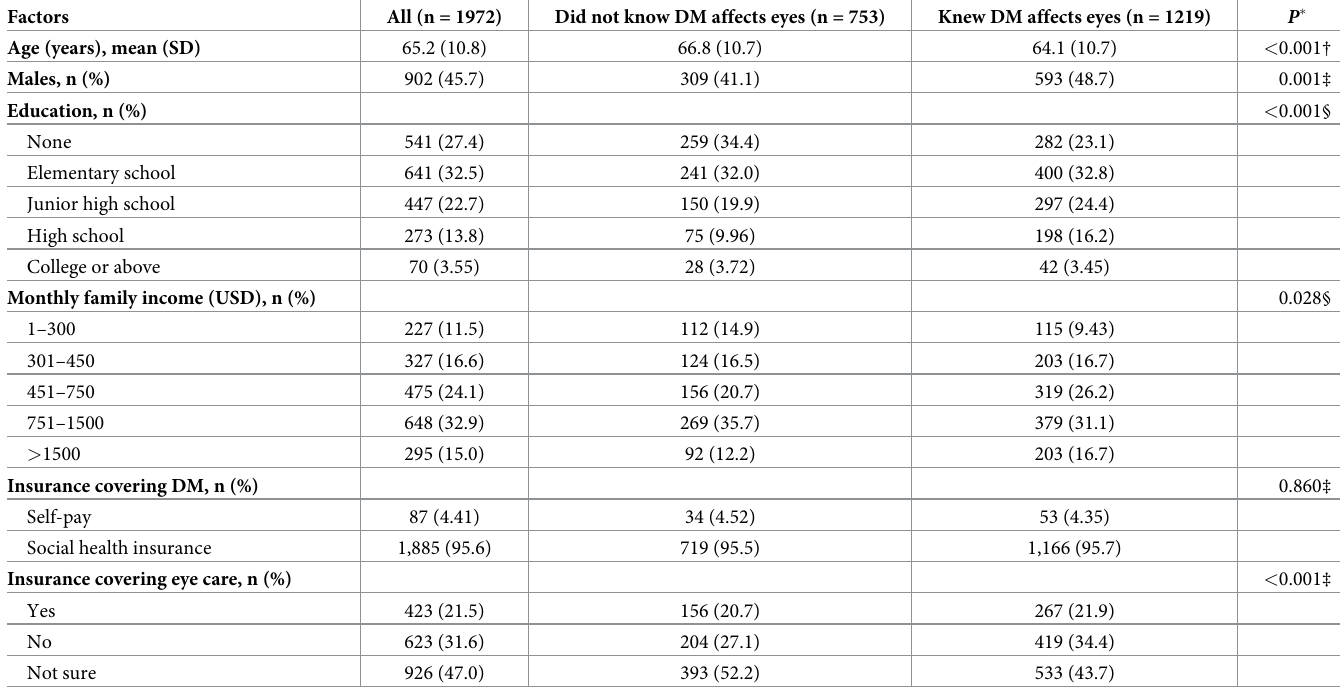
Table 1. Demographic and socioeconomic status of study